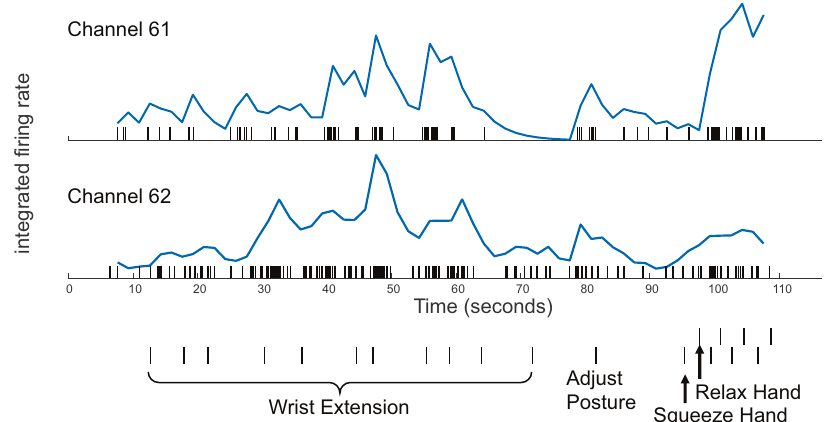
Fig. 5 Neuronal activity correlated with performed movements in the paretic limb. Over a 110-s period, the participant was asked to perform a series of left limb movements (described on abscissa). Verbal movement instructions indicated by hash marks. Rasters indicate the time of each action potential. Normalized, integrated fi ring rates appear beneath each raster, derived by a ‘ leaky integrator ’ eq. in 29 ; normalization achieved by dividing by the maximum integrated fi ring rate from each unit ’ s spike train over the time period displayed. The top unit (channel 61) is more active for hand squeezing than wrist extension, relative to the bottom, simultaneously recorded unit (channel 62). The participant performed all movements: such motions required effort and he was unable to engage a consistent level of activity for each cue and exhibited a variable reaction time. The participant was easily fatigued, requiring him to take a break and adjust posture. Numerical data that was used to generate this fi gure is available in Supplementary Data